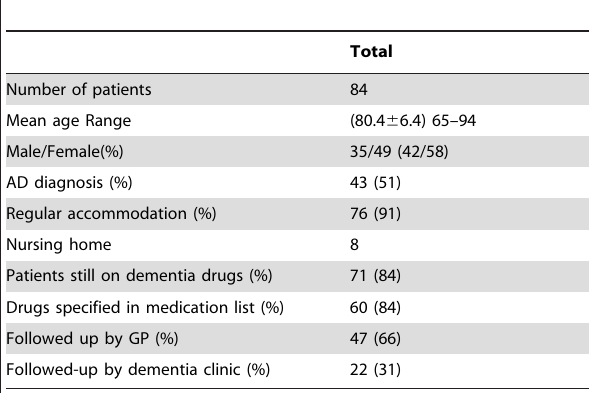
Table 4. Follow-up group: Demographic data and follow-up